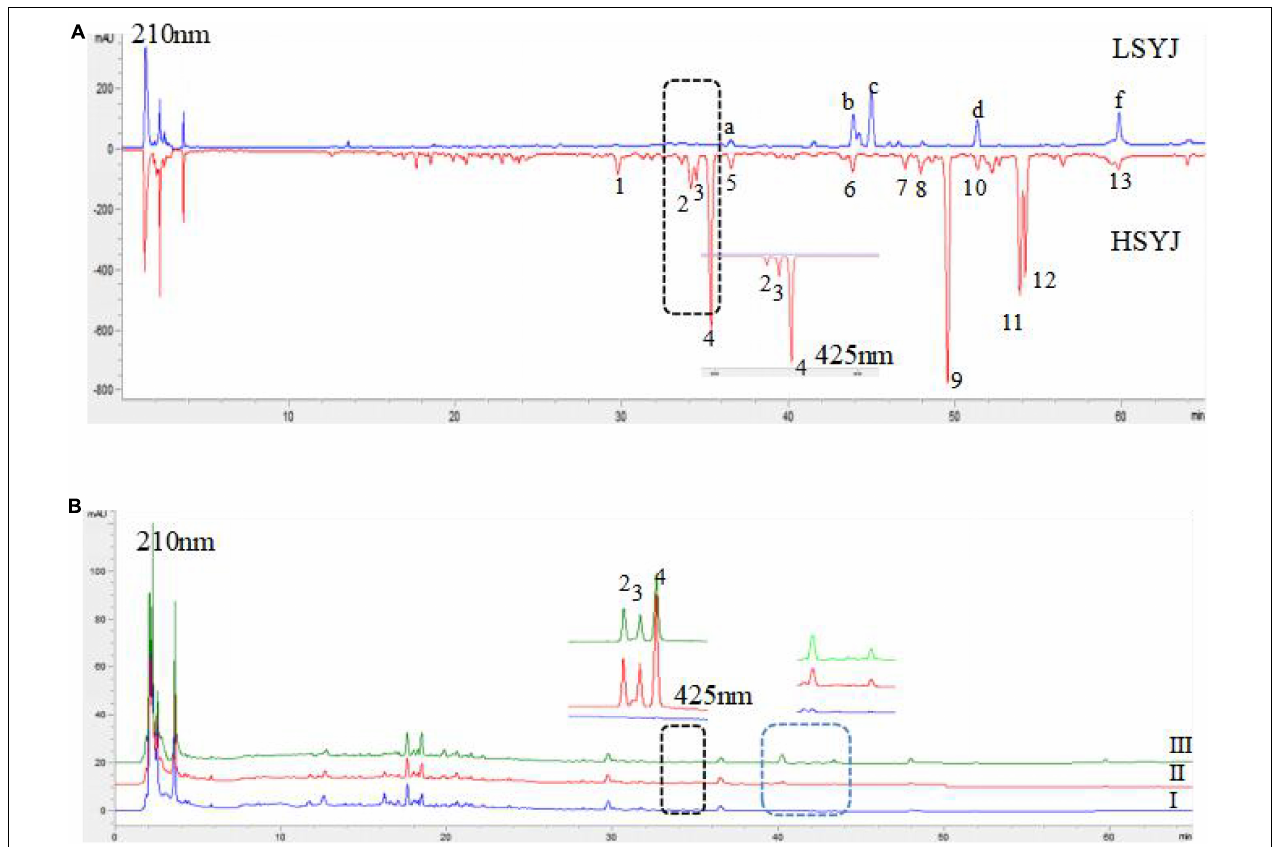
FIGURE 1 | HPLC characteristics spectra of Sample 1 (A) and Sample 2 (B) . HSYJ, Curcumae Longae Radix; LSYJ, Curcuma phaeocaulis Radix(2) bisdemethoxycurcumin, (3) demethoxycurcumin, (4) curcumin, (c) Furanodienon, (f) Furanodiene, (I) raw, (II) Stir-frying with vinegar, (III) Stir-frying with